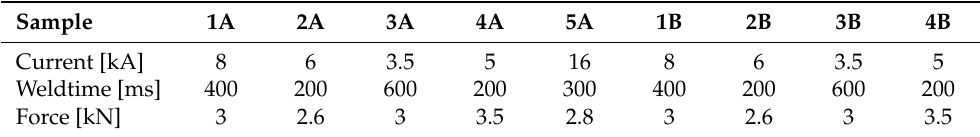
Table 1. Parameters used to generate the